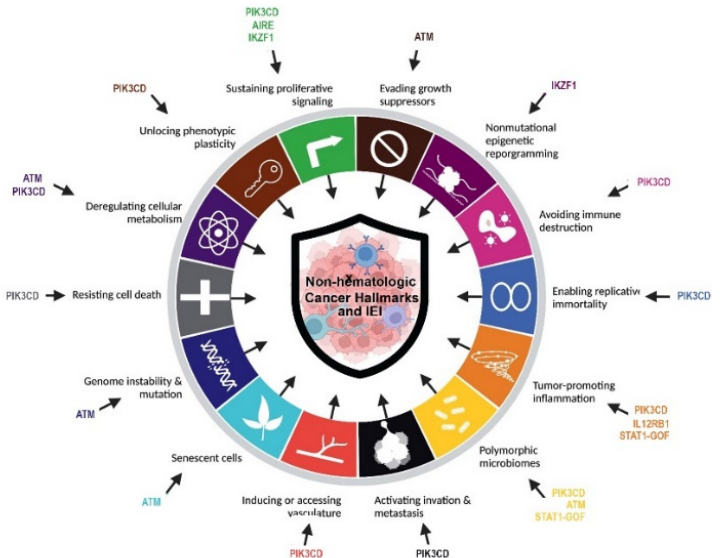
Figure 3. Cancer hallmarks in non-hematologic cancers of IEI patients according to the underlying discovered monogenic defects.